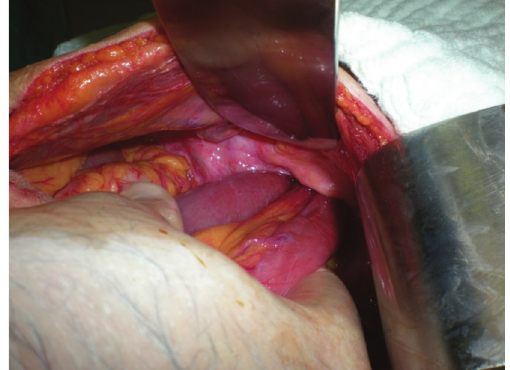
Figure 2: Strangulated small intestine segment protruding through the obturator canal.